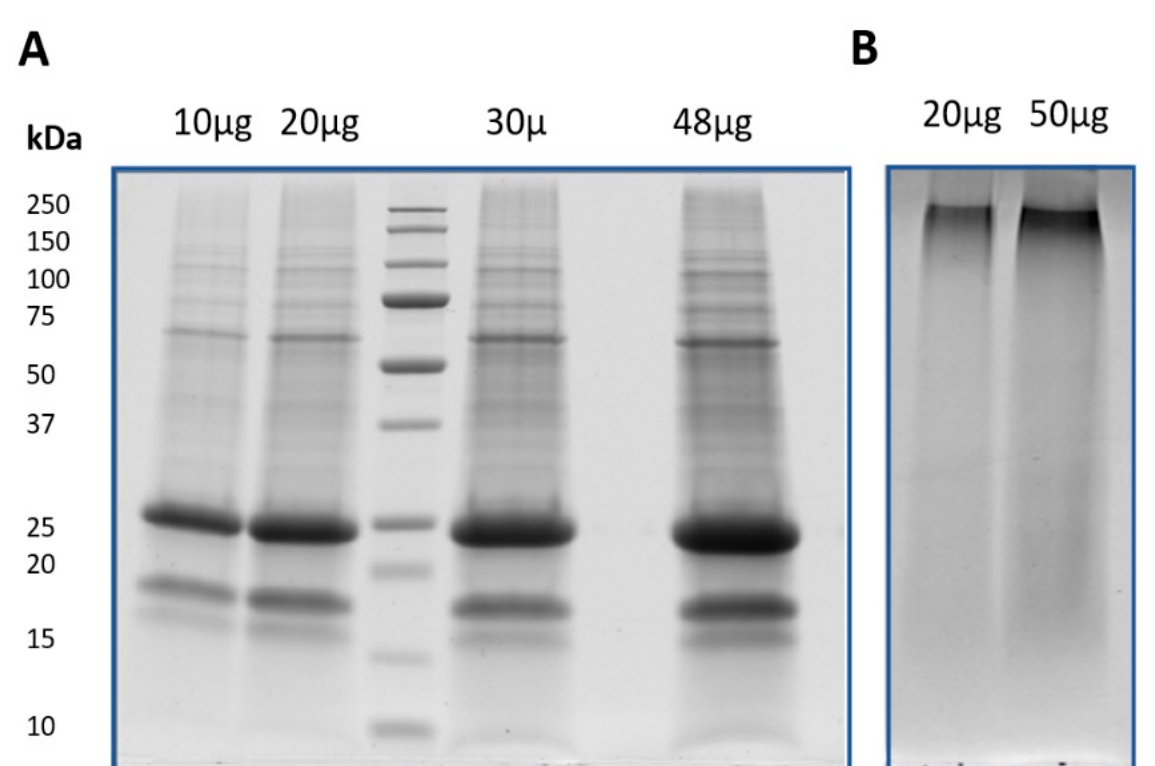
Figure 2. Electrophoretic profiles of protein samples obtained by phenol extraction method. ( A ) SDS-PAGE results of ginseng loading 10, 20, 30, and 48 µg of proteins; ( B ) SDS-PAGE results of red Ginseng loading 20 and 50 µg of proteins.